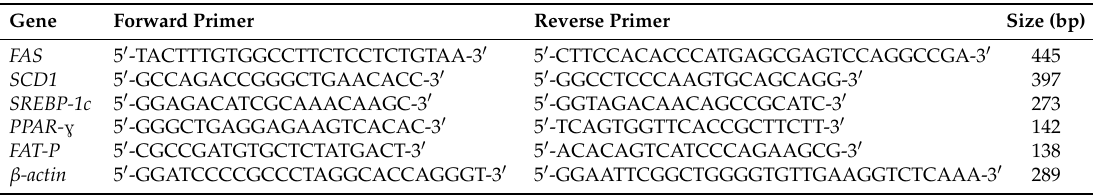
Table 3. Oligonucleotide sequence of primers for